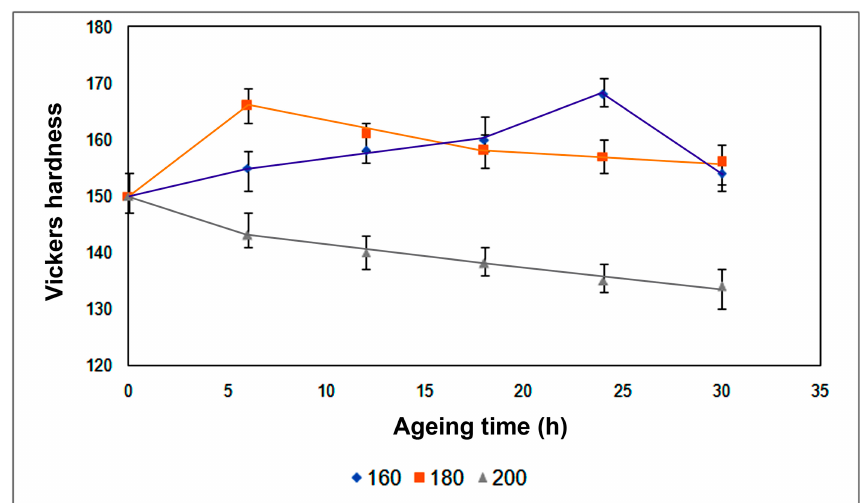
Figure 13. Hardness profiles of the samples treated at 495 °C for 8 h and subsequently cold rolled until achieving a deformation of 25%, with ageing treatments at 160, 180, and 200 °C, respectively. Error bars define the distance between the maximum and minimum values vs. the average value.